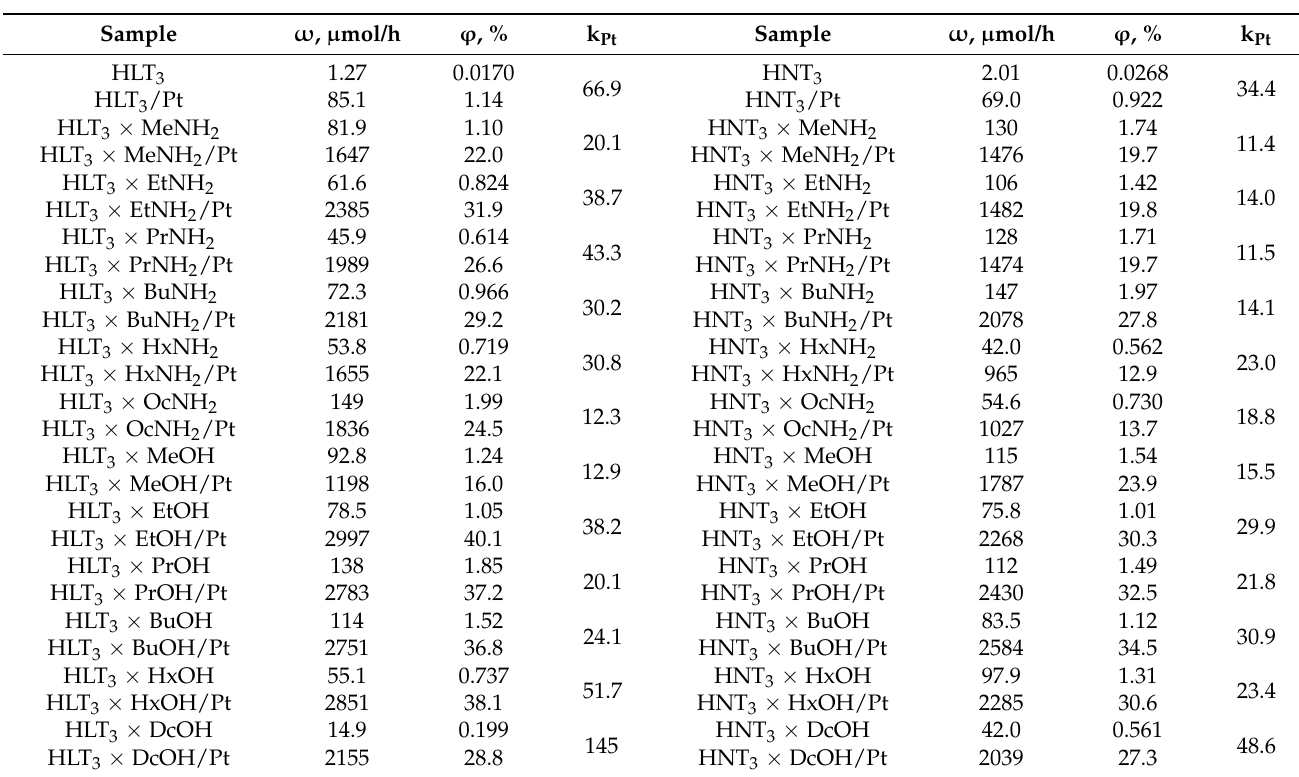
Table 4. Data on photocatalytic activity of the protonated titanates and their inorganic-organic derivatives. Sample